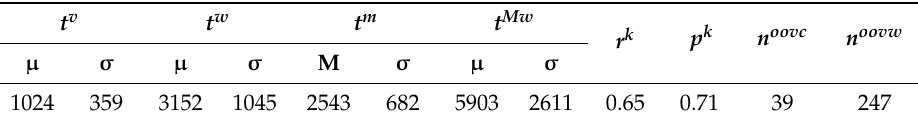
Table 3. The mean and the standard deviation of the model parameters estimated on TTS . The times are in milliseconds. OOV , out-of-vocabular y.